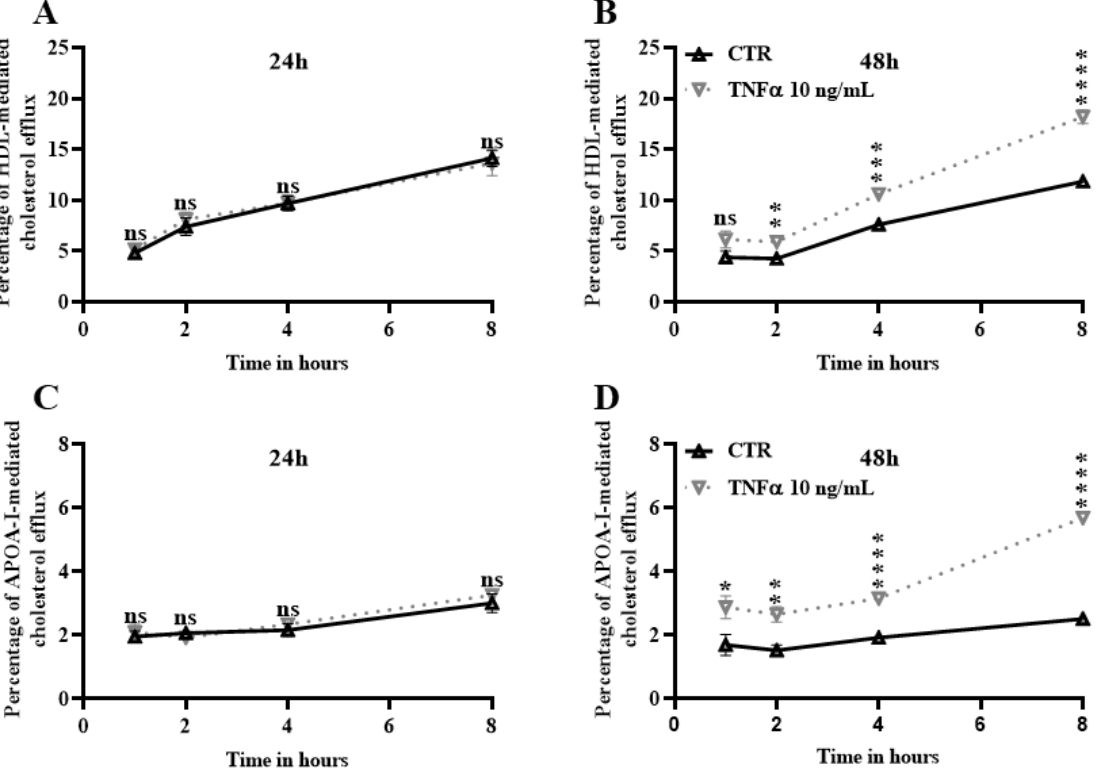
Figure 5. Cholesterol efflux is increased after 48 h of treatment with TNF α . Radiolabeled cholesterol efflux to lipid acceptors was measured after 24 and 48 h of treatment with TNF α (10 ng/mL) during 1, 2, 4, and 8 h. Control condition (CTR) refers to the cells treated only with vehicle as described in the Materials and Methods section. HDL (50 µg/mL)-mediated cholesterol efflux is shown in ( A , B ). APOA-I (20 µg/mL)-mediated cholesterol efflux is shown in ( C , D ). Each time point represents the mean ± SEM of two independent experiments within three replicates each (N = 2; n = 6). Statistical analysis: Student’s t -test, ns: non-significant * p < 0.05, ** p < 0.01, *** p < 0.001, **** p <